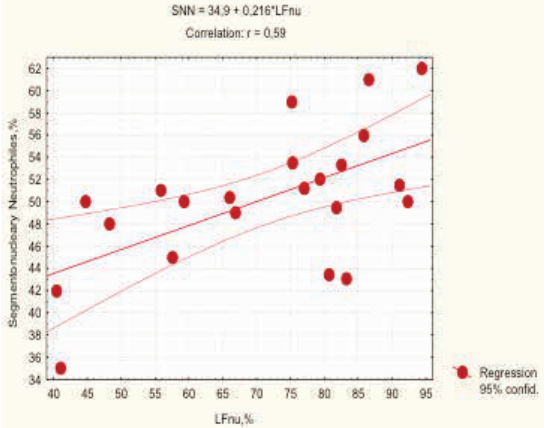
Figure 2: Relationship between normalized power LF HRV (X-line) and blood level of Segmentonucleary Neutrophiles